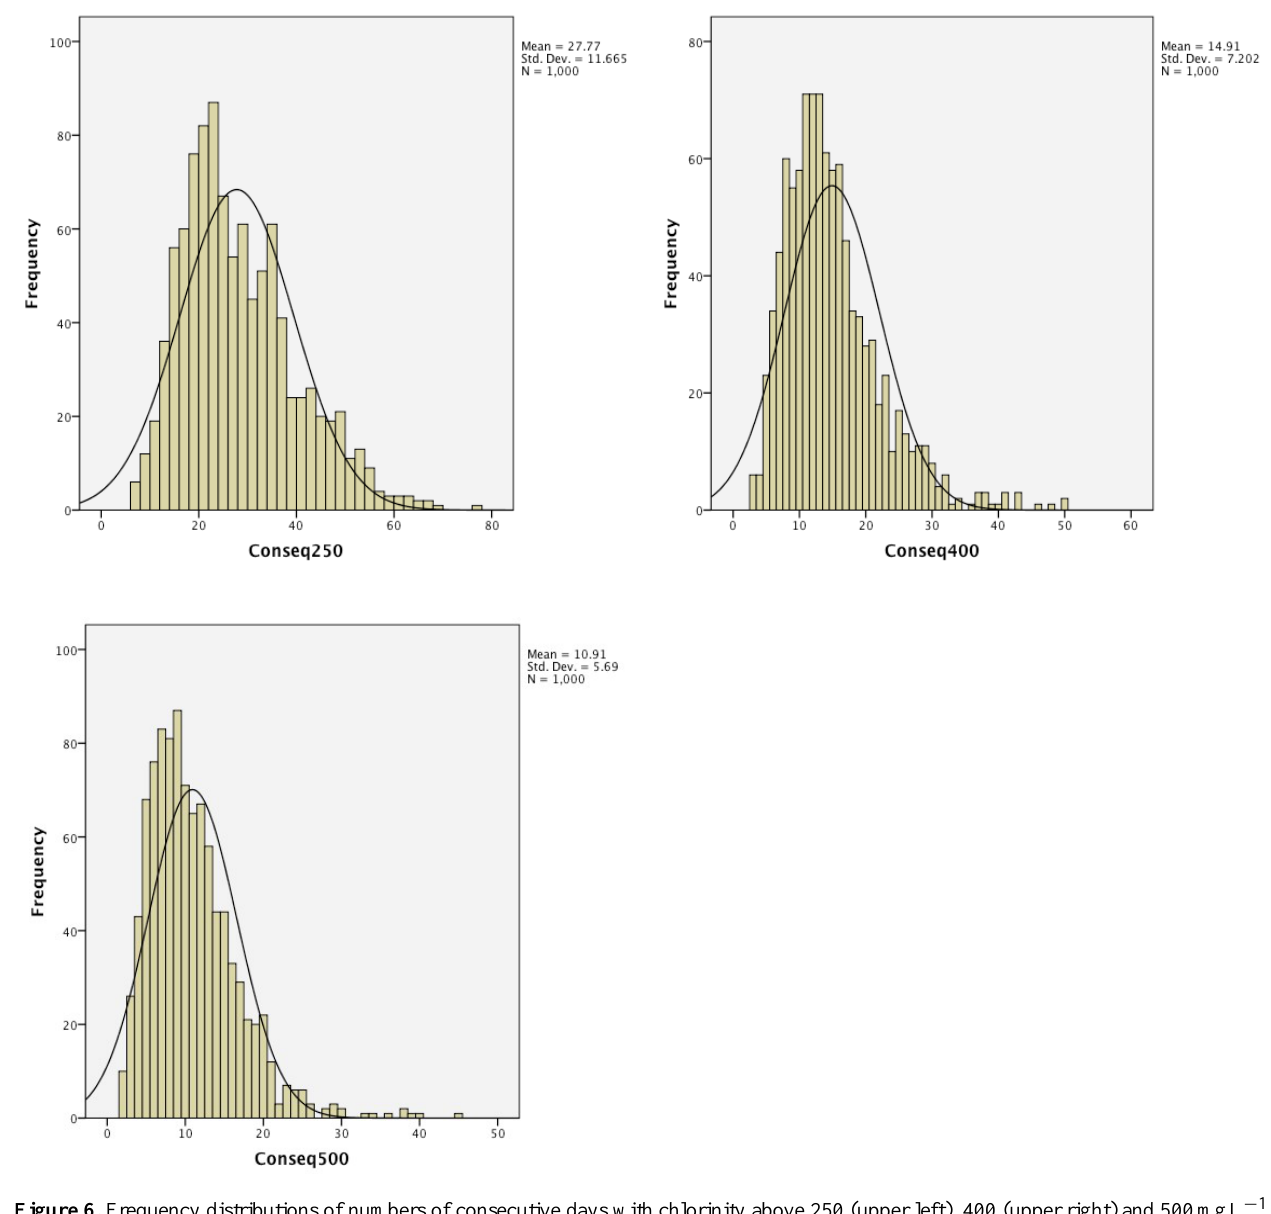
Figure 6. Frequency distributions of numbers of consecutive days with chlorinity above 250 (upper left), 400 (upper right) and 500mgL − 1 (lower left), fitted with Weibull distributions for